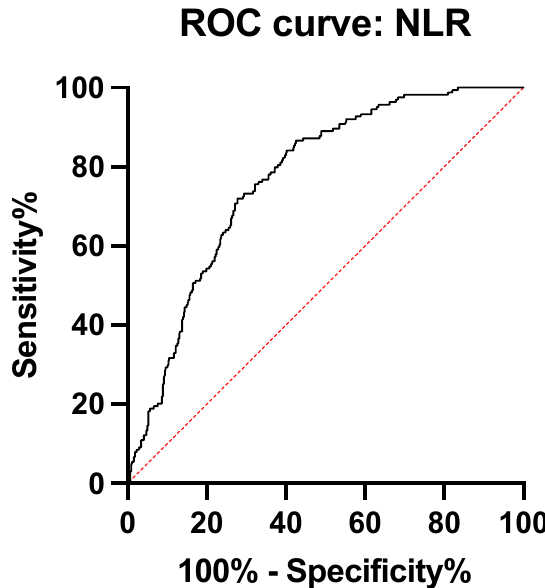
obtained an area under the curve = 0.68 (AUC), with 95% CI of 0.64 to 0.74, p < 0.0001. The cut-off point with the best sensitivity (63.41%) and specificity (64.14%) was 201.4 (Figure 2, Table 3).